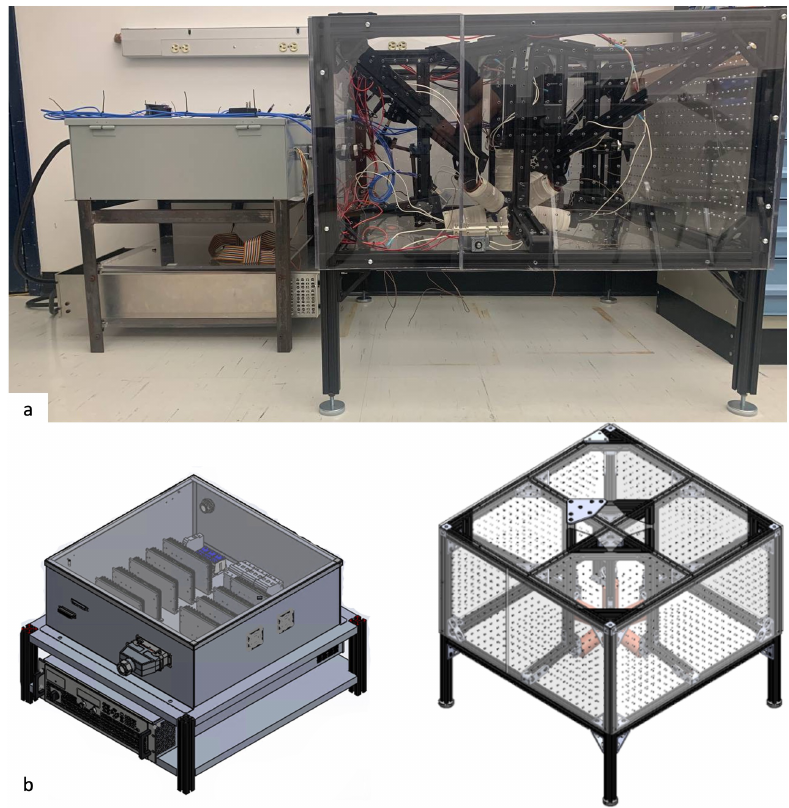
Figure 19. ( a ) Fabricated frame and ( b ) designed